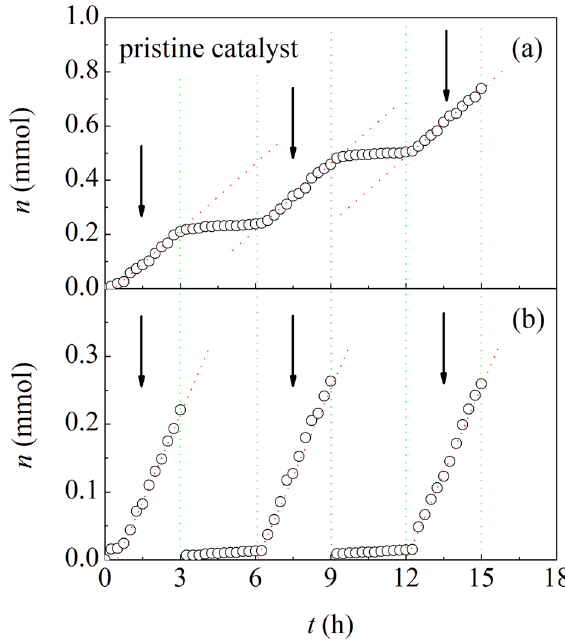
Figure 2. The number of CO moles reacted under BM conditions over pristine catalyst powders, n , as a function of time, t . Data refer to experiments in which ( a ) BM was interrupted and the vial never opened, and ( b ) BM was interrupted and the vial opened. Arrows indicate the time intervals during which the pristine catalyst powders were subjected to BM. Best-fitted lines (dotted, red) are